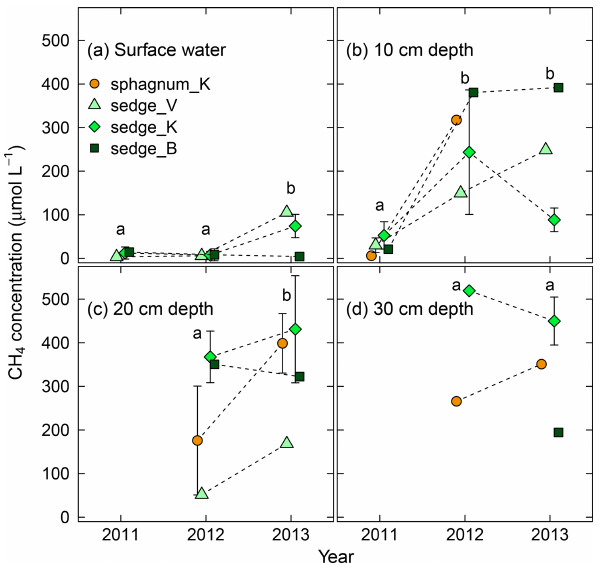
Figure 5. In situ δ 13 C versus δ D of dissolved CH 4 in (a) surface water and soil pore water at (b) 10cm in depth, (c) 20cm in depth, and (d) 30cm in depth from the wetting event in 2011 to 2013. Individual delta values are shown here. See Table S3 for averaged delta values for each observation point and each